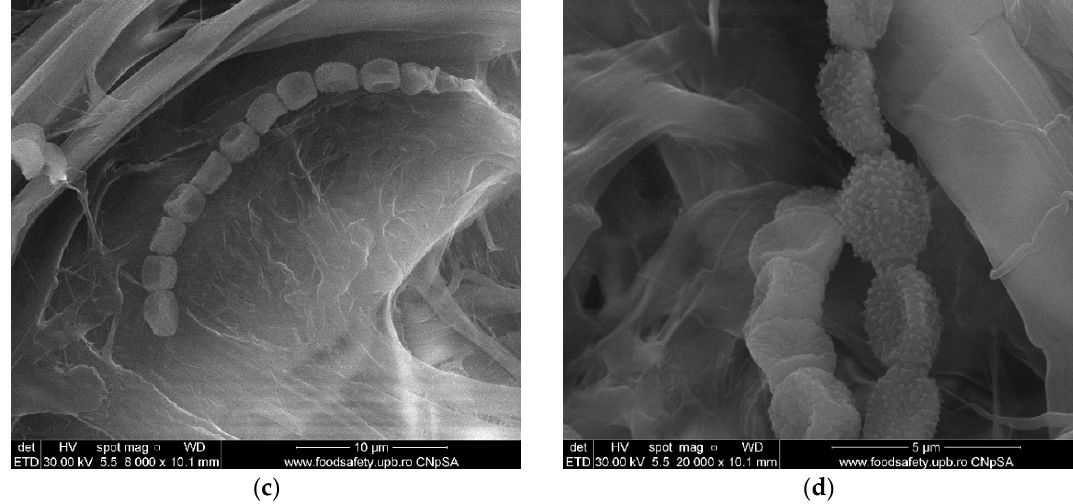
Figure 8. Di ff erent microorganisms found in paper sample A ( a , b ) and sample B ( c , d ). Figure 8. Different microorganisms found in paper sample A ( a , b ) and sample B ( c , d ).